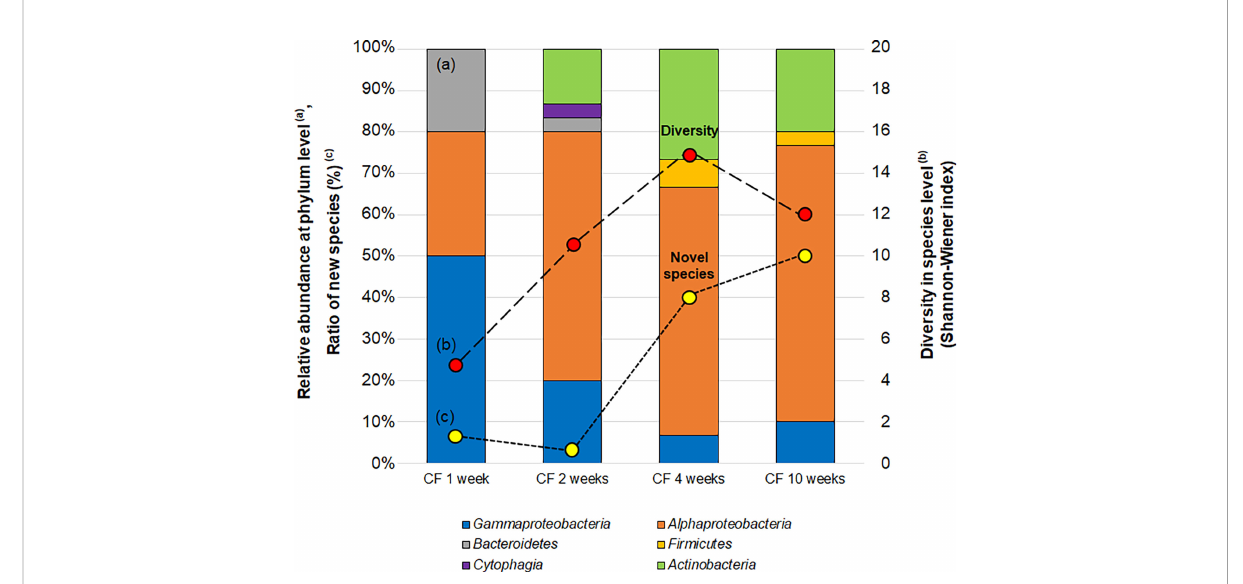
FIGURE 6 Changes in the bacterial community (a; bar graph), diversity (b; red circle) and proportion of novel species (c; yellow circle) of isolates CF (continuous- fl ow bioreactor) cultivation at 1, 2, 4 and 10 weeks. Bacterial community (A) shown as relative abundance at phylum level (class level for alpha , Gamma and Epsilon proteobacteria group). Diversities of isolates (B) are compared by the effective number of species from